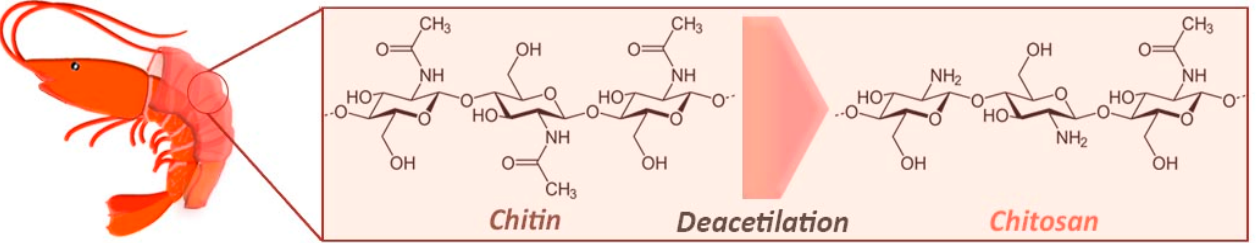
Figure 3. Chitosan production chain, from chitin extraction from shellfish exoskeleton to its deacetylation process to obtain chitosan.